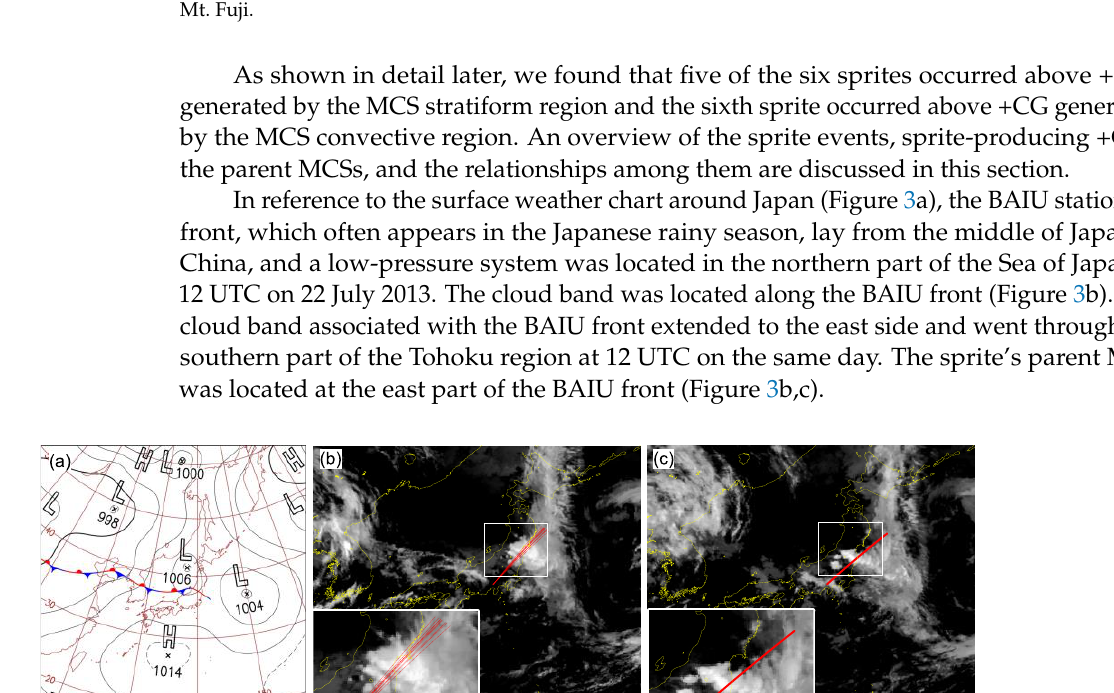
Figure 2. All sprite events on 22 July 2013 were observed from the summit of Mt. Fuji. The images are enlarged.